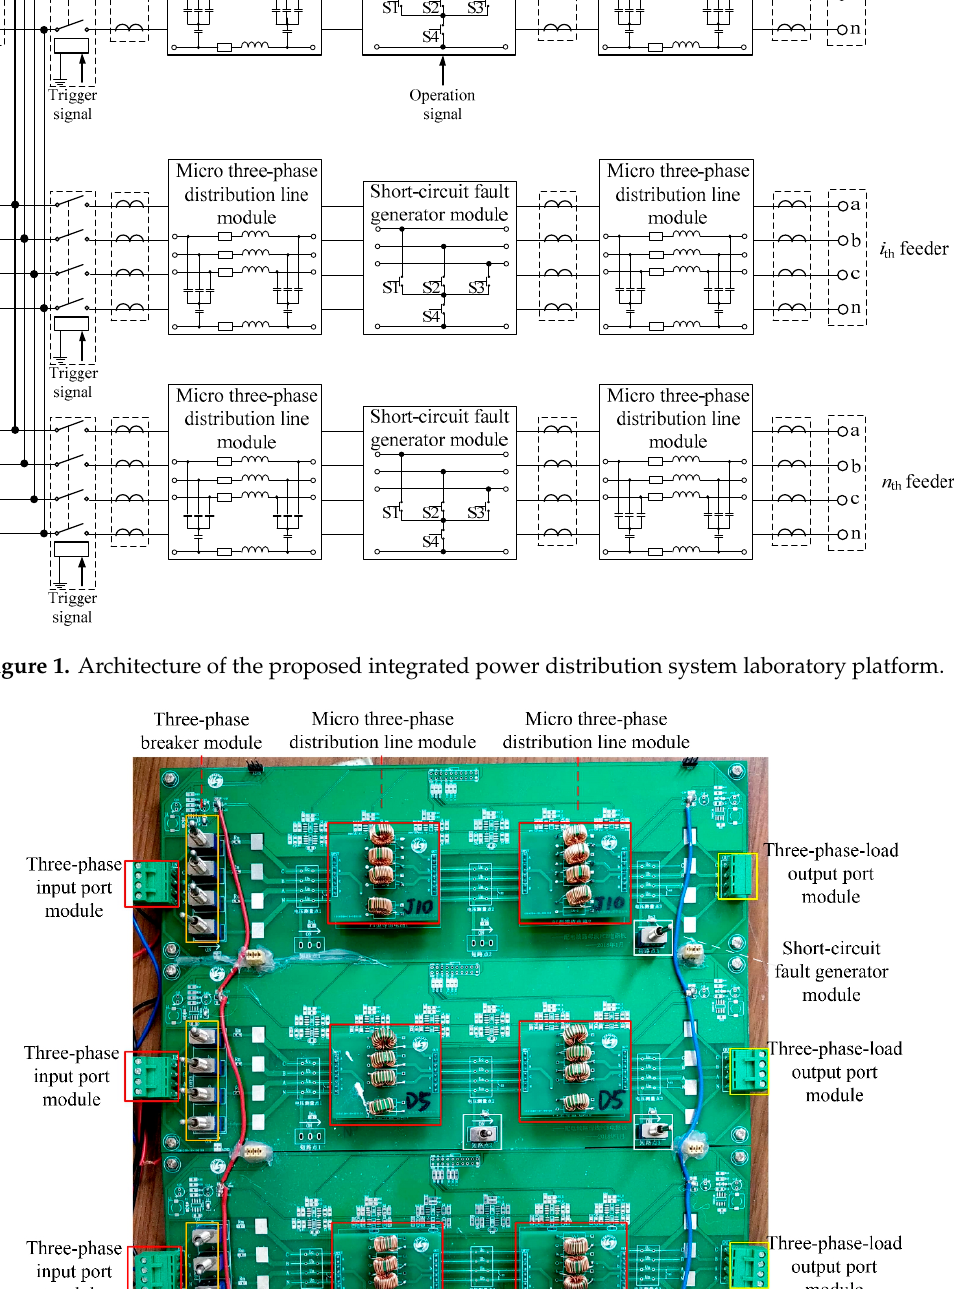
980 Table 2. Cost comparison between our platform and the commercial platform. Equipment